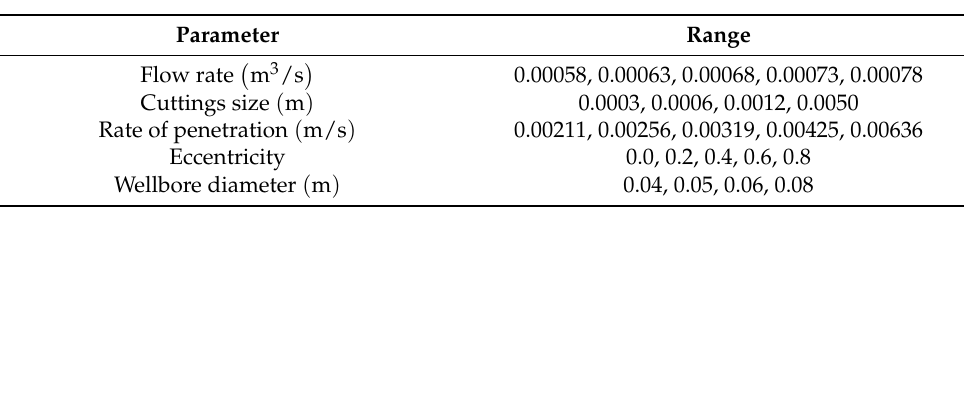
Table 2. Test matrix for cuttings transport